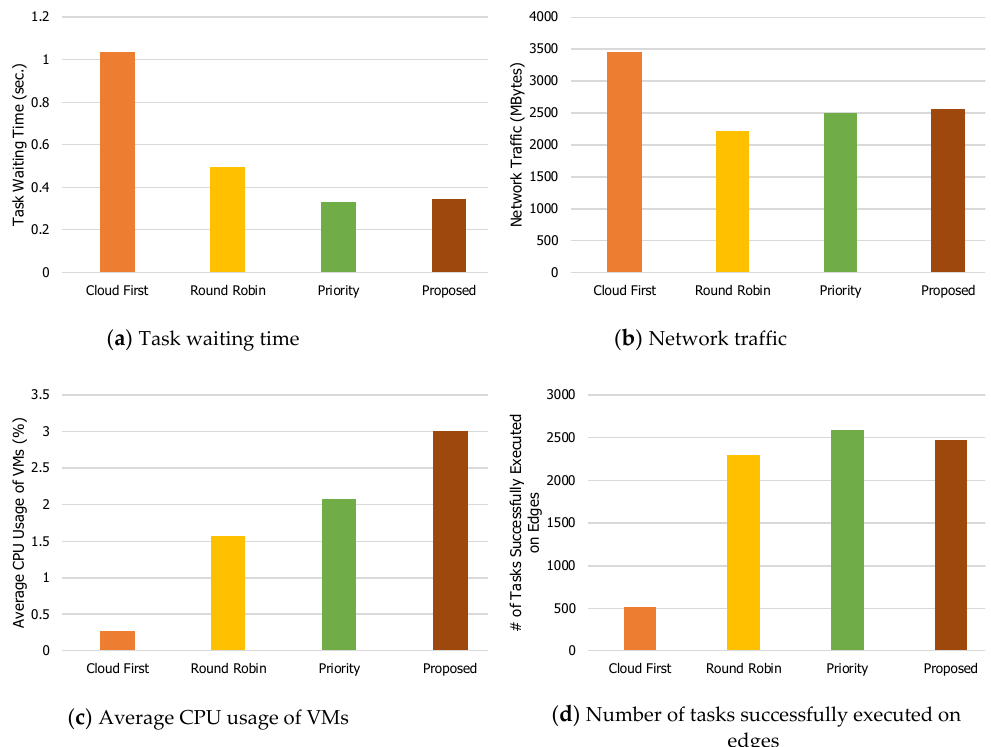
Figure 6. Performance comparisons when the number of mobile devices is